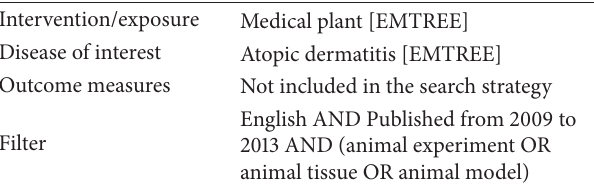
Table 2: Search strategy for